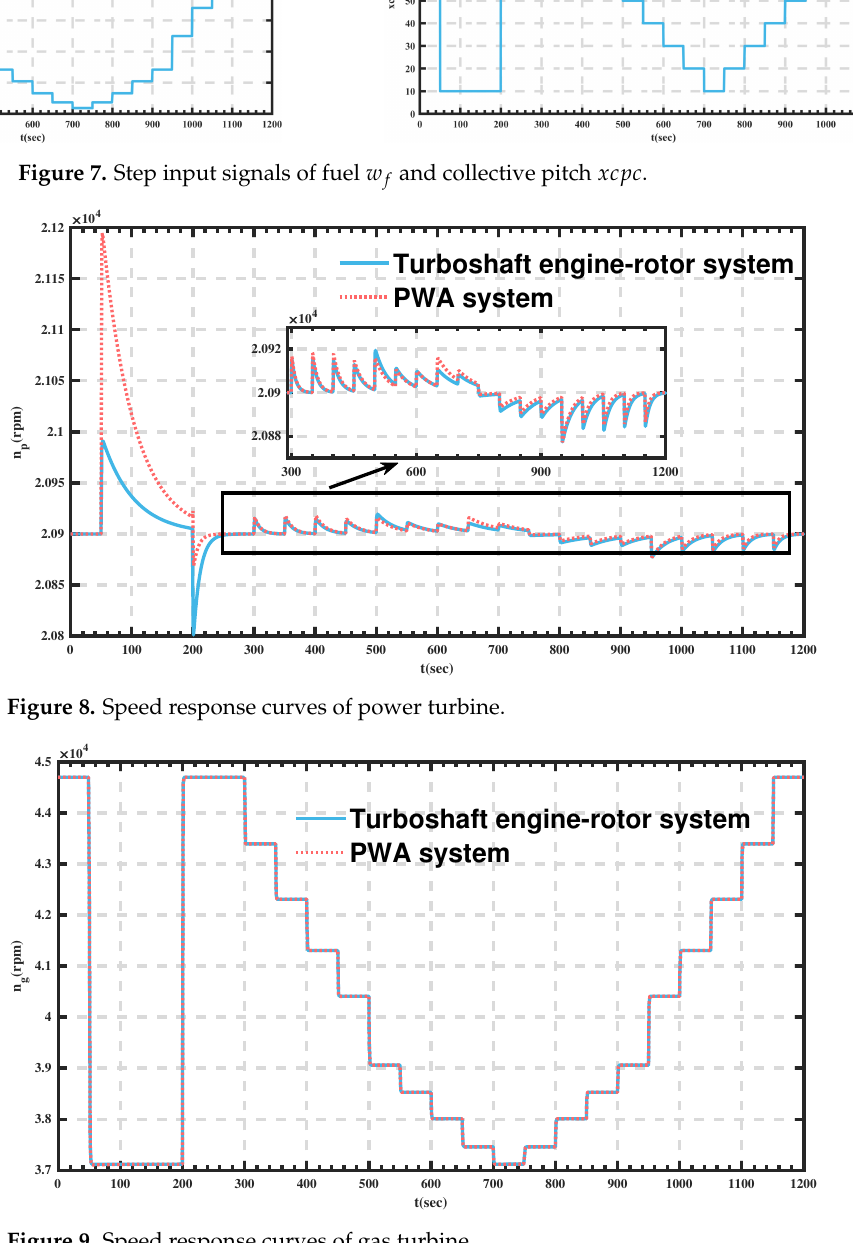
Figure 9. Speed response curves of gas turbine. (2) Figure 10 shows the ramp input signals of engine fuel w f and collective pitch xcpc of the rotor system. The speed response curves of the PWA system and the turboshaft engine–rotor system are shown in Figures 11 and 12. According to the response curves of power turbine rotation speed n p and gas turbine rotation speed n g , the steady-state and dynamic errors of n p are less than 0.24%; The steady and dynamic error of n g is less than 0.01%. Therefore, the output of the PWA system is basically consistent with